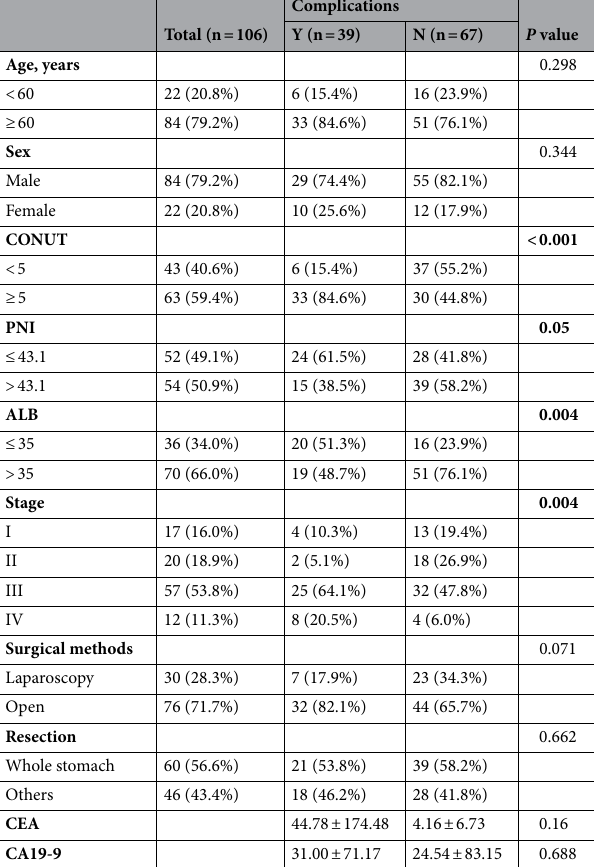
Table 4. Analysis of risk factors of postoperative